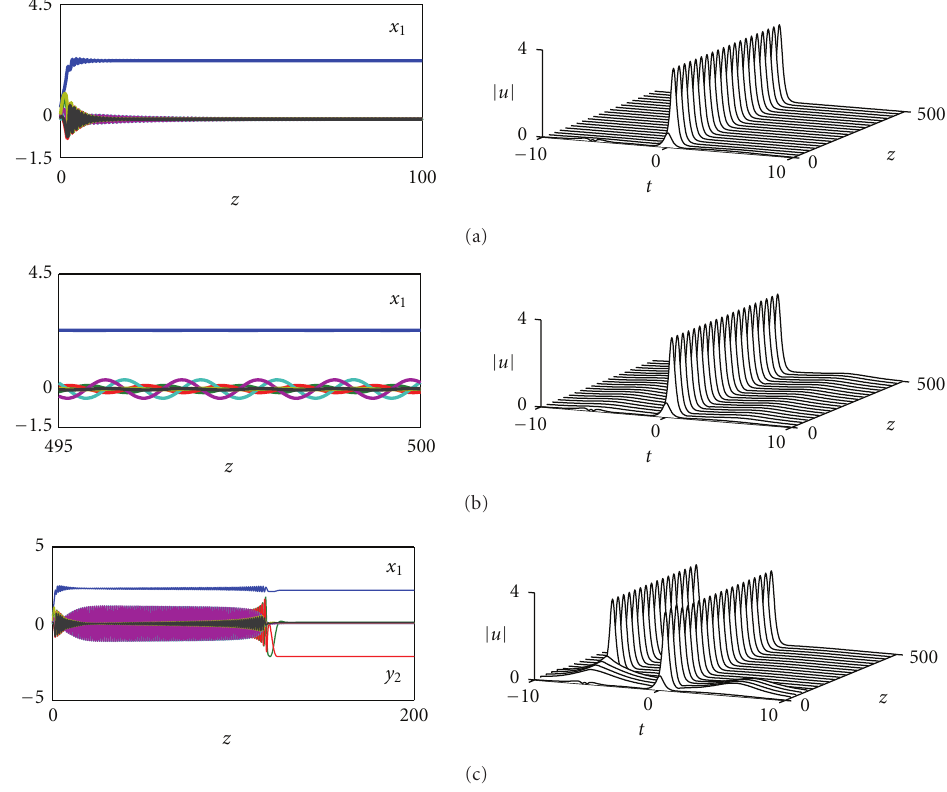
Figure 8: Left: the solution of the (1+3) model at g 0 = 3 (top), g 0 = 3 . 24 (middle), and g 0 = 3 . 8 (bottom). Here, only the significant variables (in absolute value) are labeled. Right: the corresponding reconstructed field u from the variables of the (1 + 3) model.